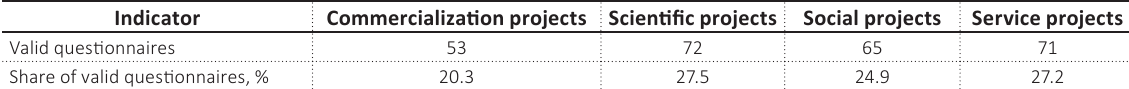
Figure 2. Organizations that participated in the survey Table 1. The research